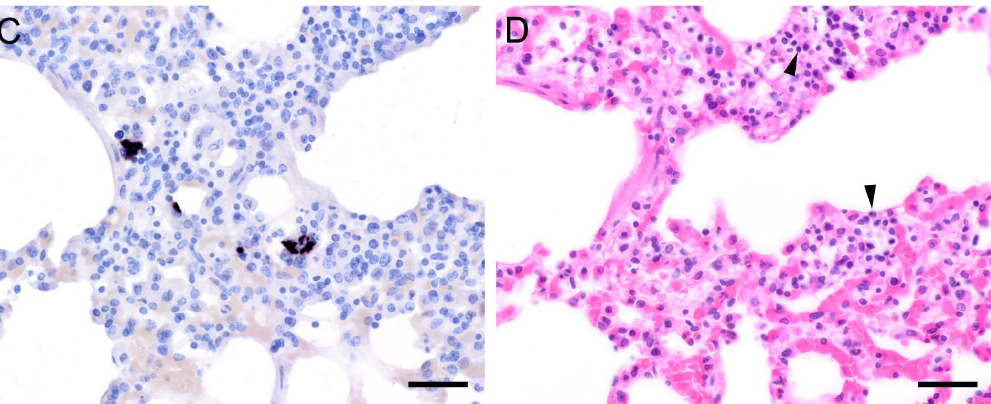
Figure 6. Adjacent sections from the same lung area of a cat and a guinea pig with mild colonization with Pneumocystis spp. are shown in comparison after ISH and H&E staining. ( A ) ISH labels single Pneumocystis organisms attached to the alveolar walls of the lung of a cat. The rest of the tissue section is Pneumocystis negative. Bar = 40 µm; ( B ) H&E staining reveals an interstitial pneumonia with mild alveolar histiocytosis (arrowheads). Bar = 40 µm; ( C ) ISH labels single Pneumocystis organisms attached to the alveolar walls of a lung of a guinea pig. Bar = 40 µm; ( D ) H&E staining reveals a granulomatous pneumonia (arrowheads). Bar = 40 µm.